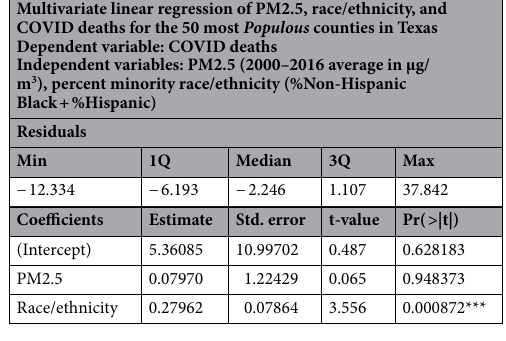
Table 1. Regression of PM 2.5, race, and COVID-19 deaths for the 50 most populous counties in Texas. Signif. codes: 0 ‘***’ 0.001 ‘**’ 0.01 ‘*’ 0.05 ‘.’ 0.1 ‘ ’ 1. Multiple R-squared: 0.2167, Adjusted R-squared: 0.1833. Residual standard error: 10.35 on 47 degrees of freedom. F-statistic: 6.5 on 2 and 47 degrees of freedom, p-value: 0.003219.